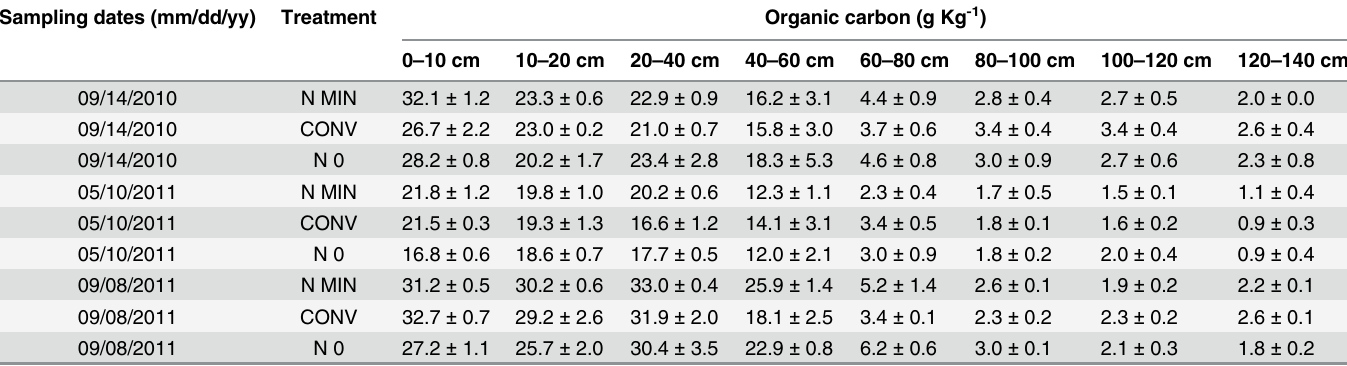
Table 4. Means and standard errors of organic carbon content in soil profile layers related to three sampling dates during the maize-triticale-maize rotation for the N MIN, CONV and N0 treatments (n = 3). Sample dates correspond to the harvest of maize (09/14/2010), triticale (05/10/2011) and maize (09/08/2011). Dates are reported as